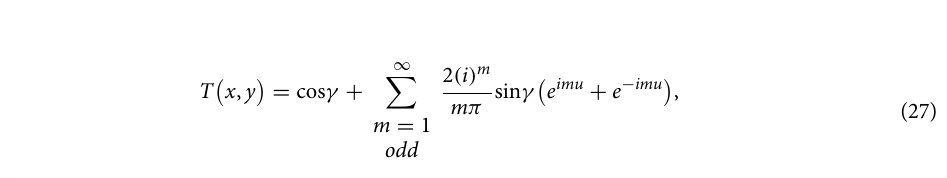
Table 1. The characteristics of E7 Liquid crystal at a temperature of 25 °C and a wavelength of 632.8 nm 38,39